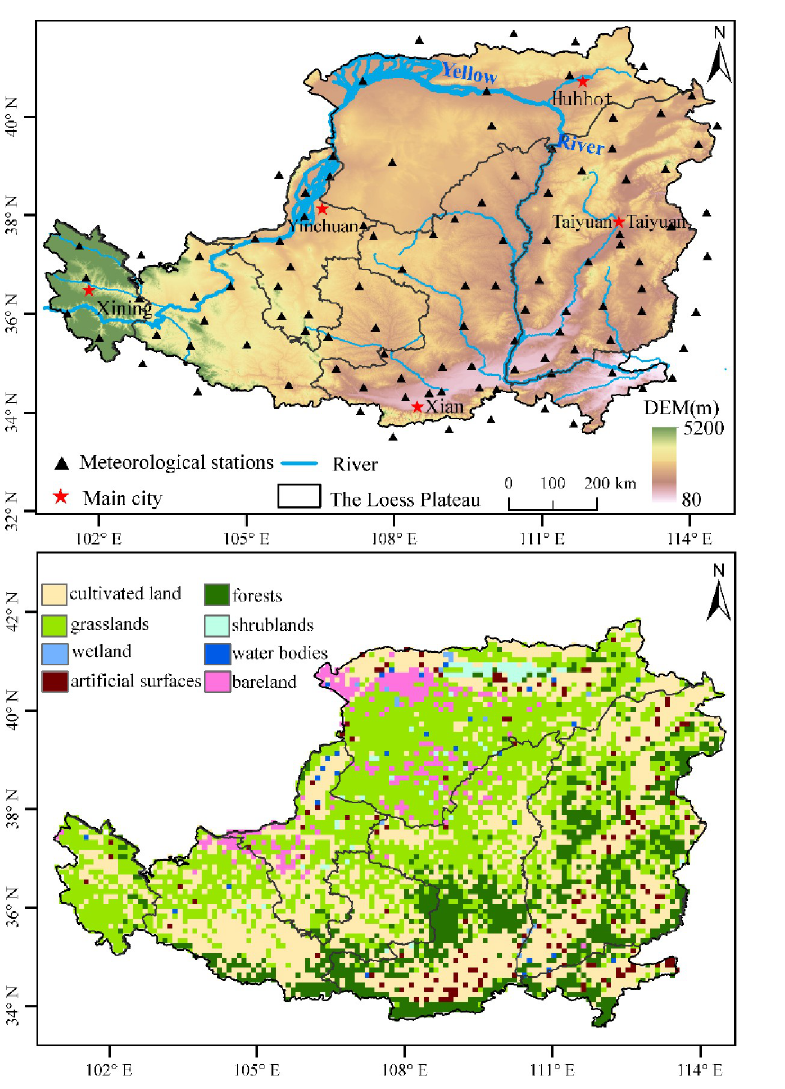
Fig 1. The altitude, meteorological stations, and vegetation types across the Loess